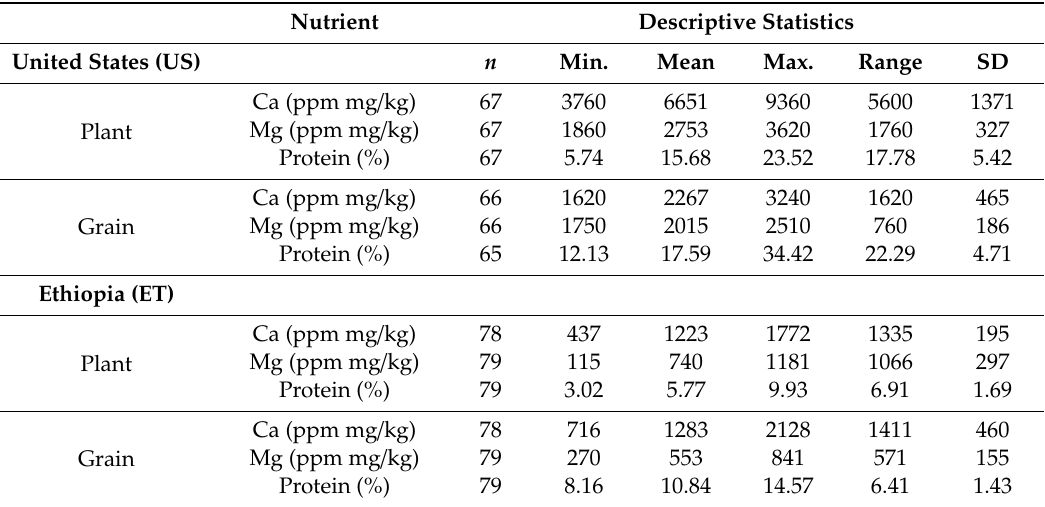
Table 2. Descriptive statistics for the calcium (Ca), magnesium (Mg), and protein measured for the plant and grain samples from each